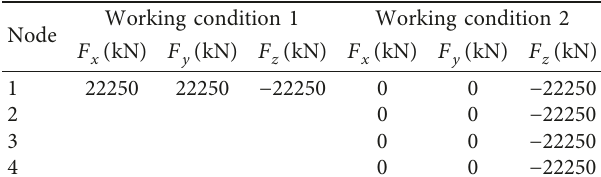
Figure 11 [46]. The structure considers two load conditions. The specific working conditions are shown in Table 9.